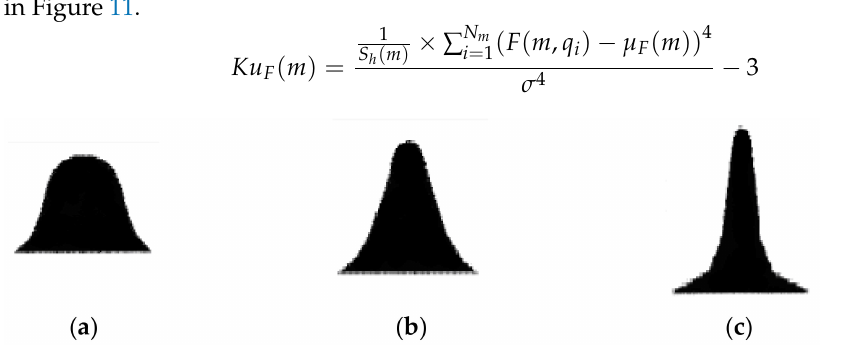
Figure 11. The shape of the kurtosis distribution: ( a ) negative value; ( b ) equal to zero; ( c ) positive